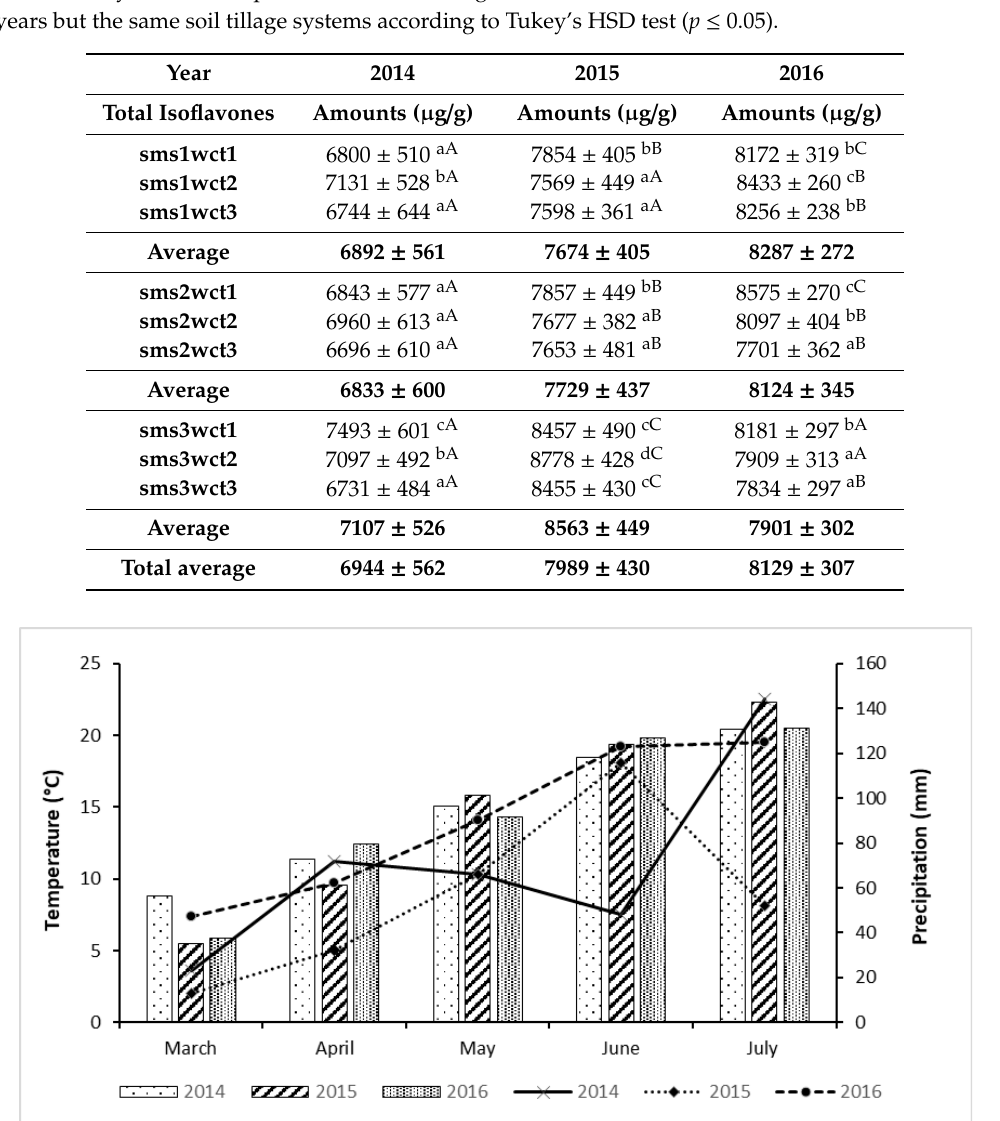
Figure A1. Thermic and pluviometric chart. The average precipitation (represented by lines) and temperature (represented by bars) determined at the experimental site in Turda, Romania, during the growing period (2014–2016).